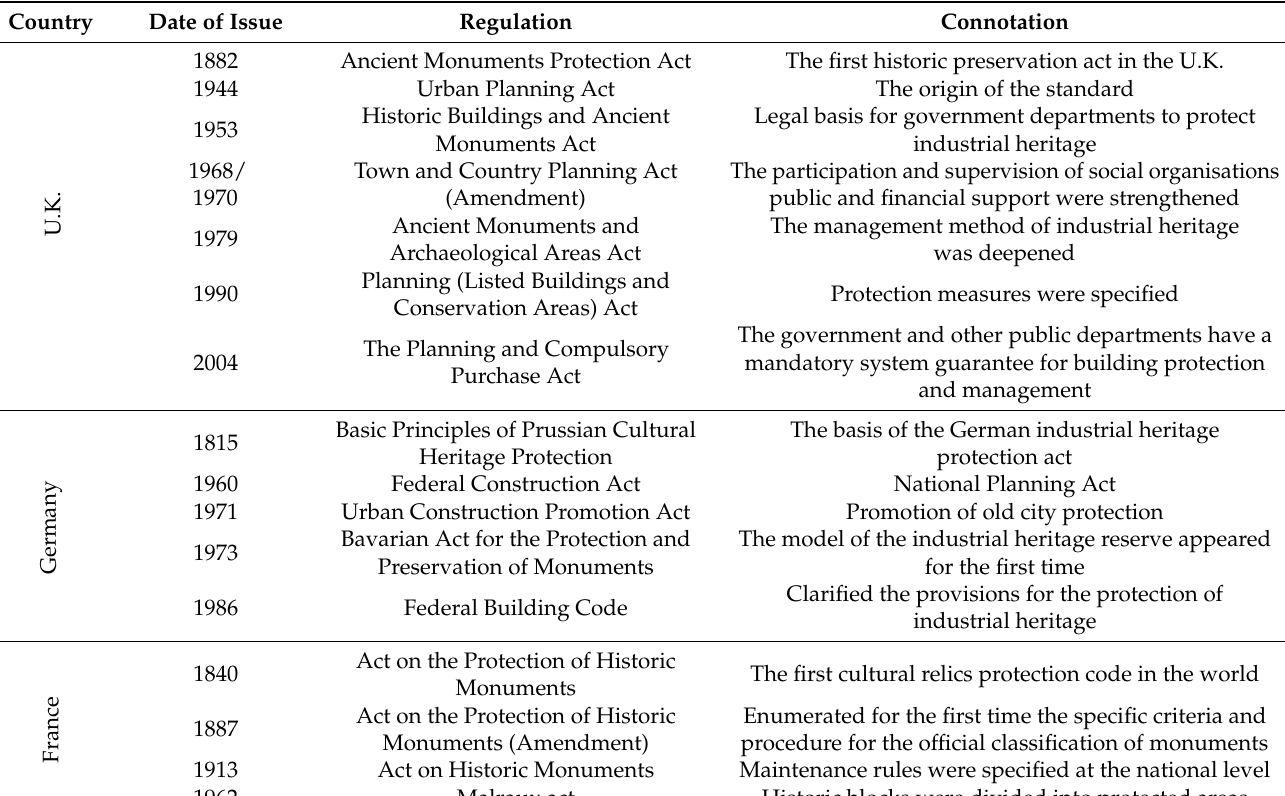
Table 2. Evolution of major legal provisions for the protection of industrial heritage in typical Western European